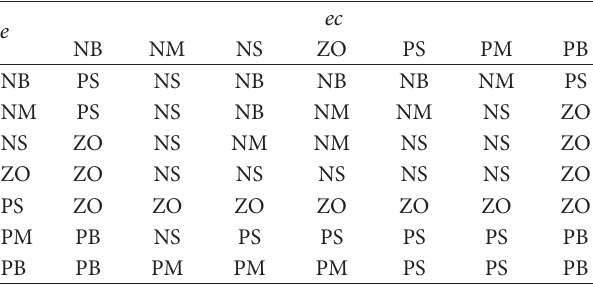
Table 3: Fuzzy control rule table for Δ𝑘 𝑑